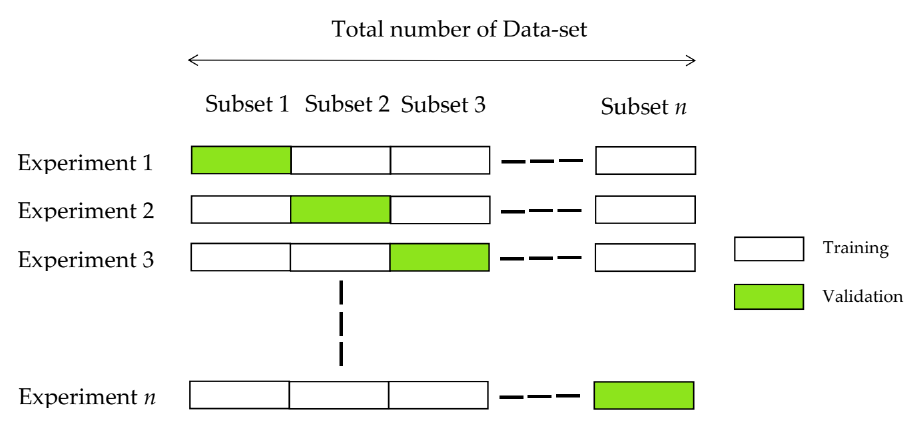
Figure 11. An n -fold cross-validation.